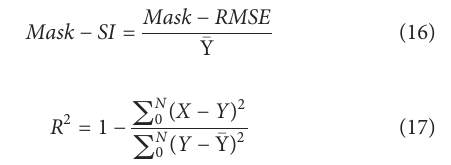
FIGURE 5 Architecture of the proposed